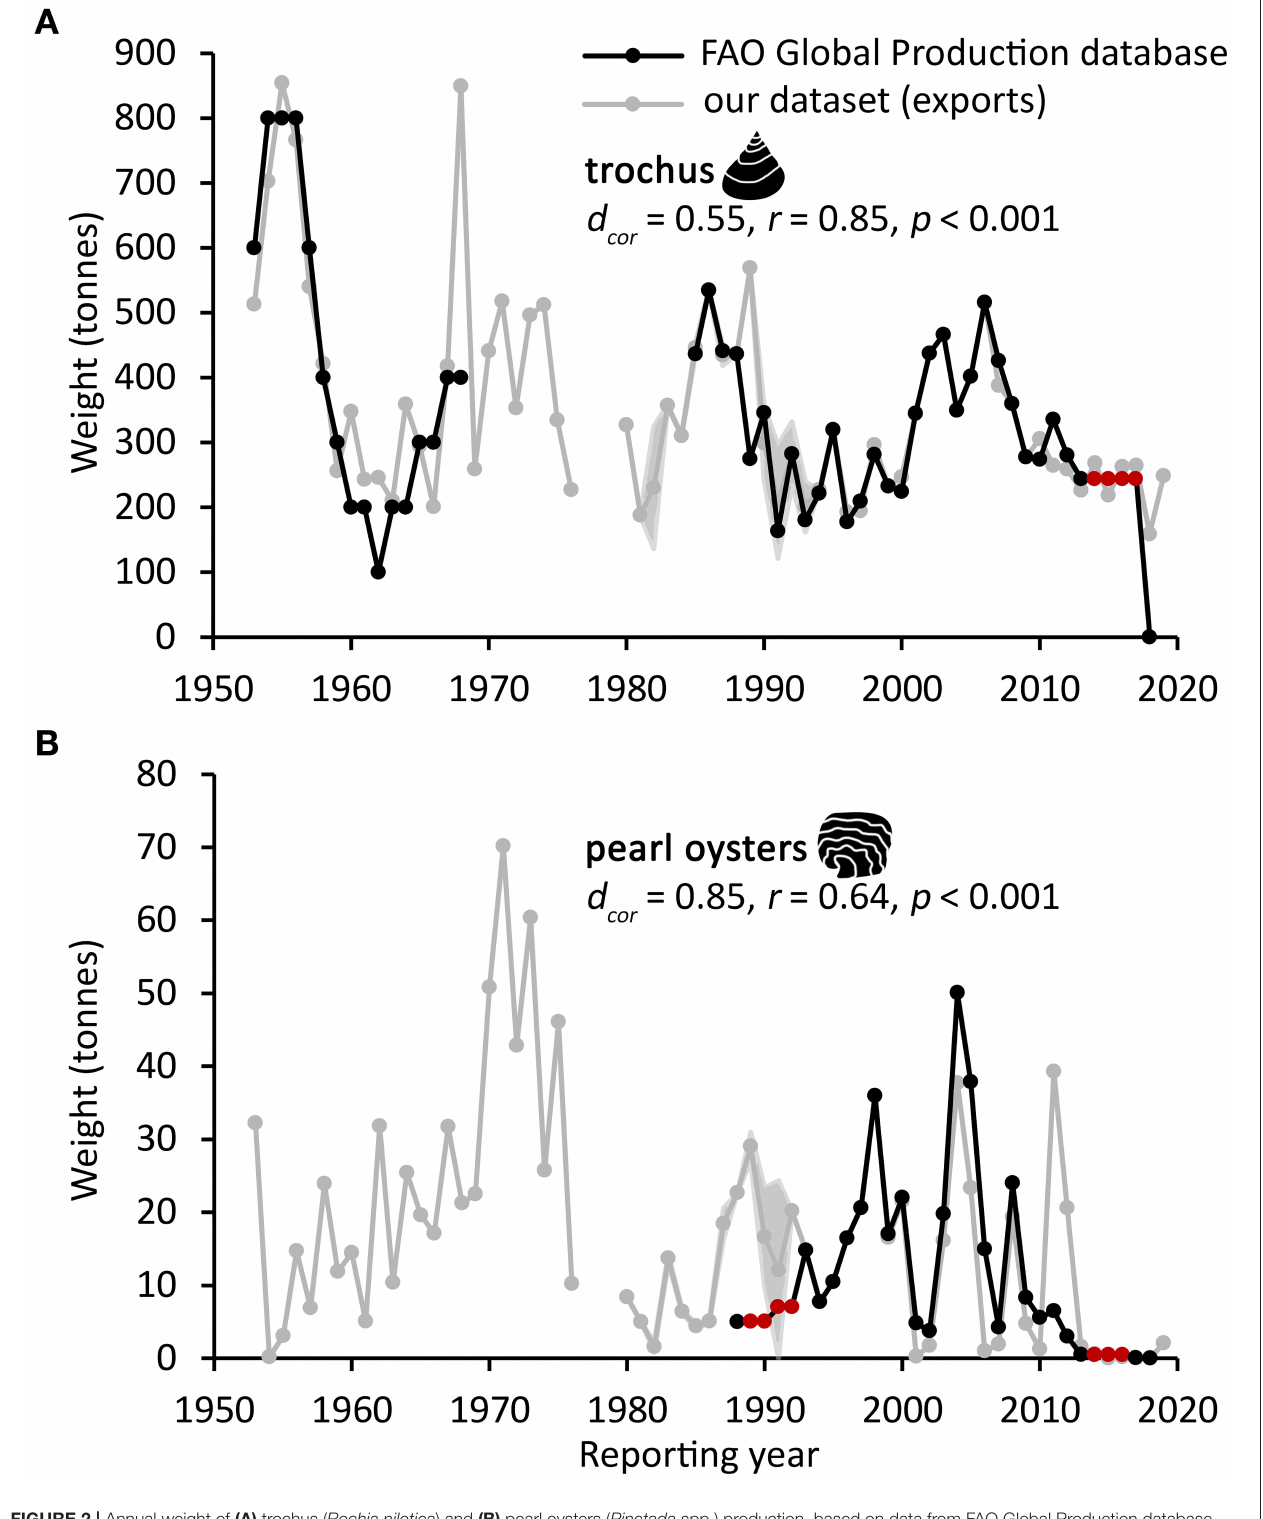
FIGURE 2 | Annual weight of (A) trochus ( Rochia nilotica ) and (B) pearl oysters ( Pinctada spp.) production, based on data from FAO Global Production database (black lines), and exports, based on data from our dataset (grey lines), for Papua New Guinea since 1953. FAO estimates for missing data (red points) and the 95% confidence interval of exports (shading) are